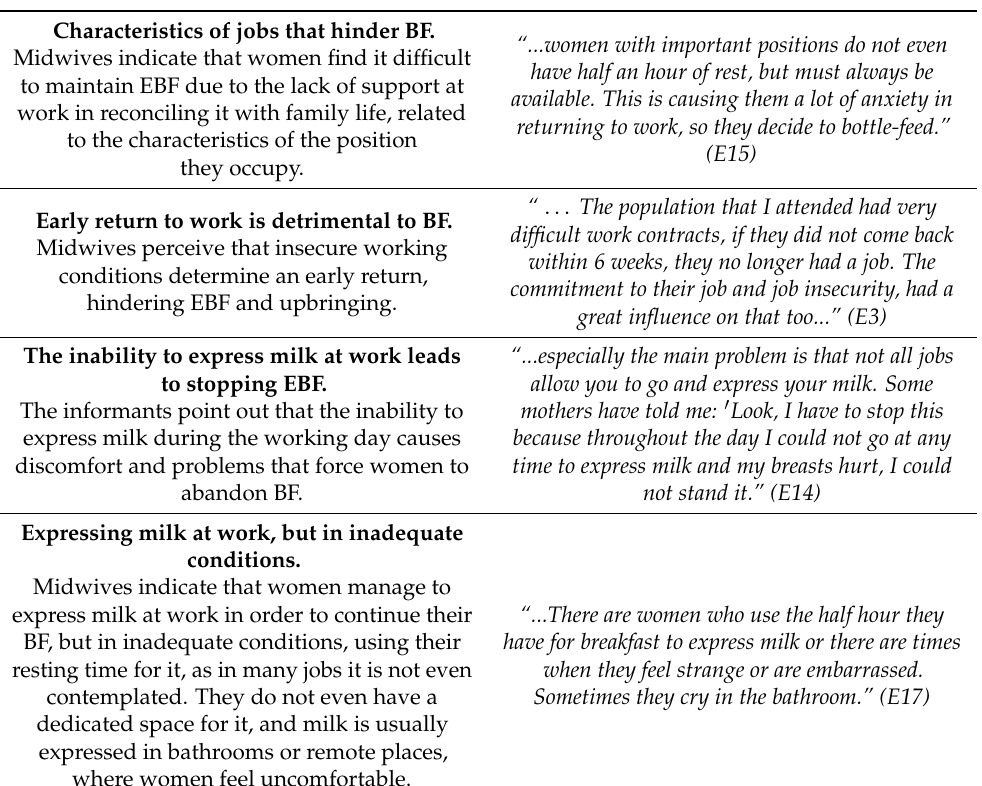
Table 4. Work characteristics that harm